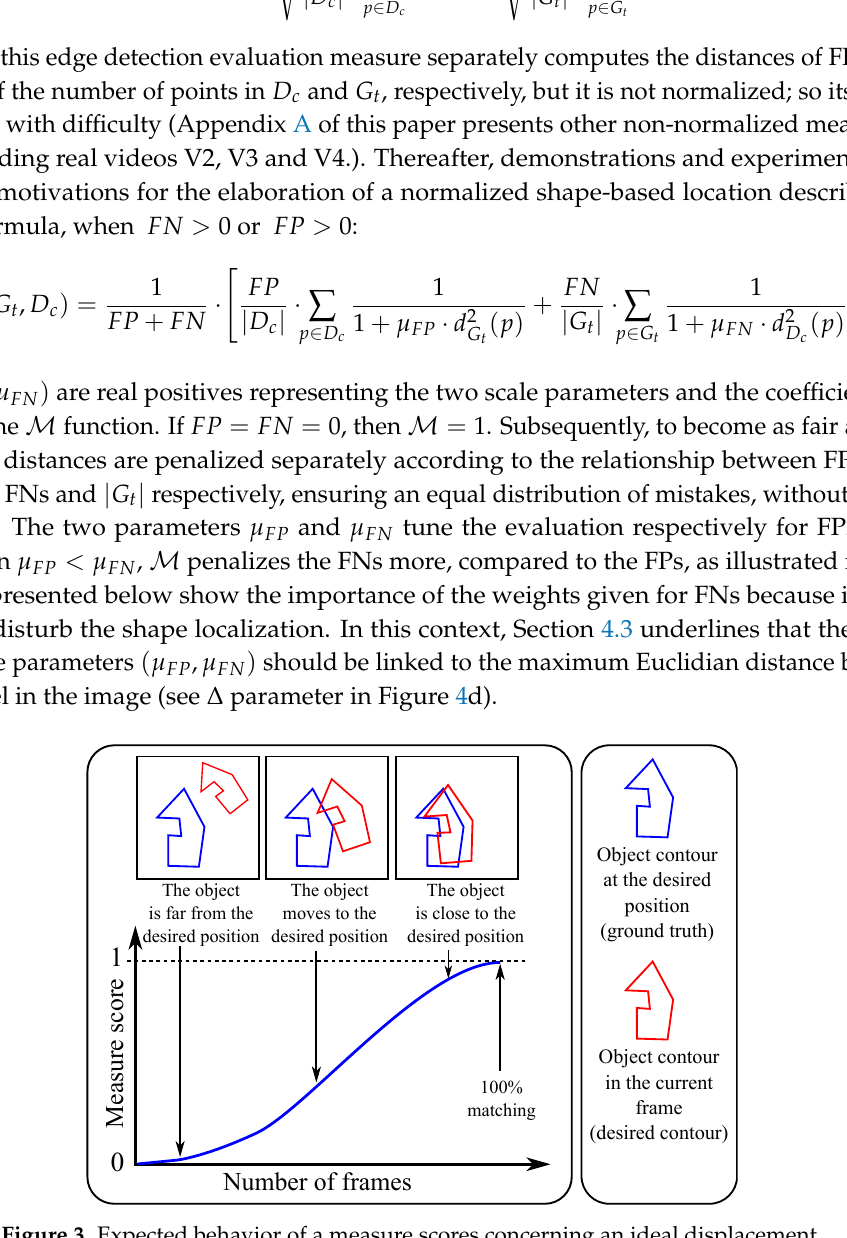
Figure 3. Expected behavior of a measure scores concerning an ideal